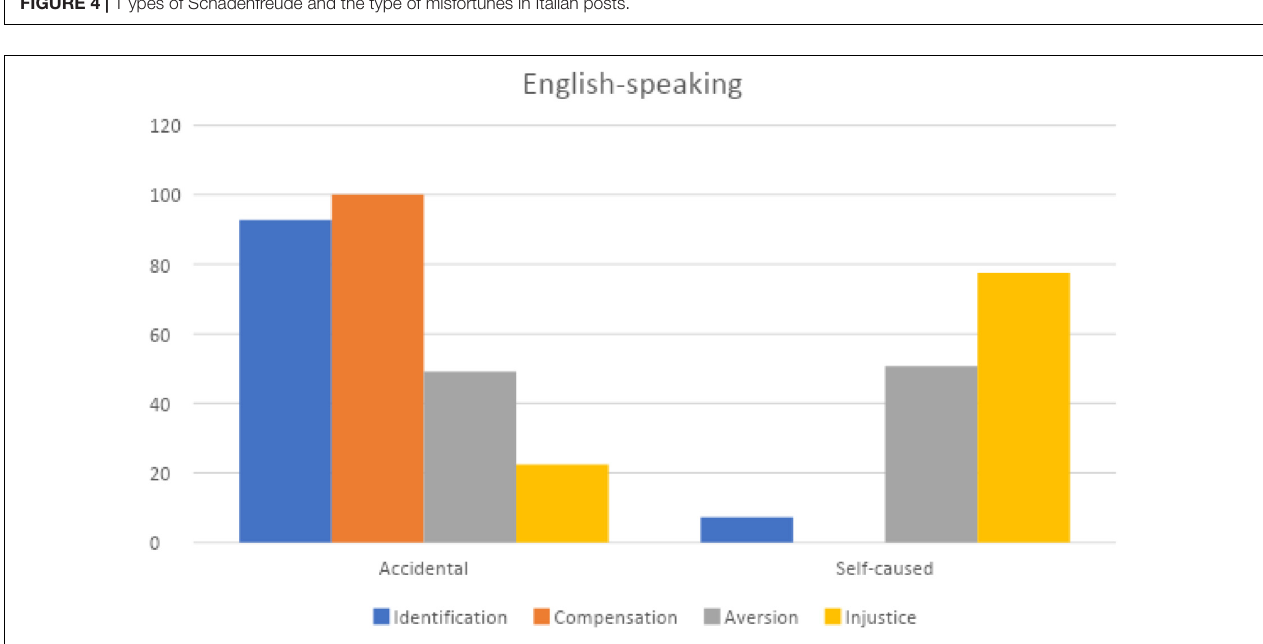
FIGURE 4 | T ypes of Schadenfreude and the type of misfortunes in Italian posts.